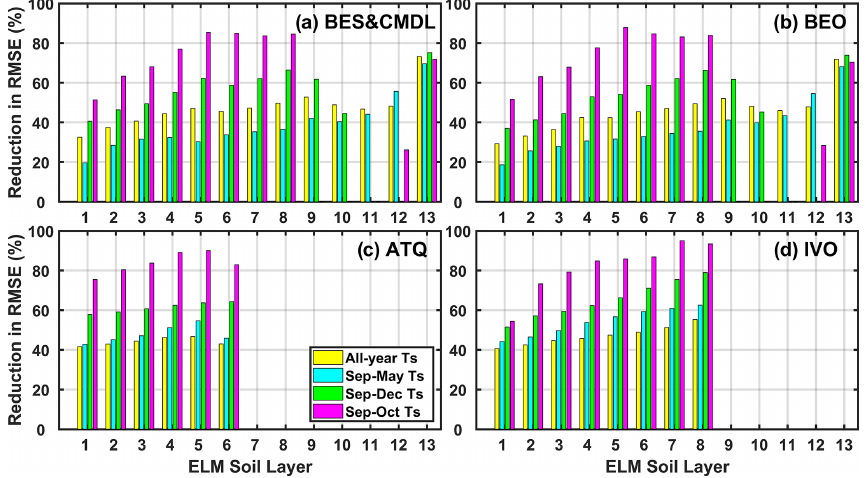
Figure 4. Relative improvement in the RMSE of simulated soil temperature with the new phase-change scheme compared to that with